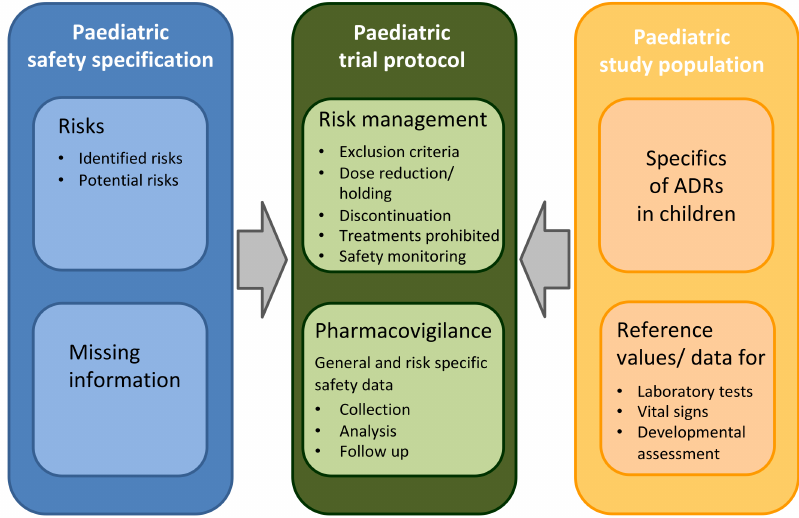
Figure 3. Relationship between paediatric safety specification and protocol development. ADR— Adverse drug reaction.